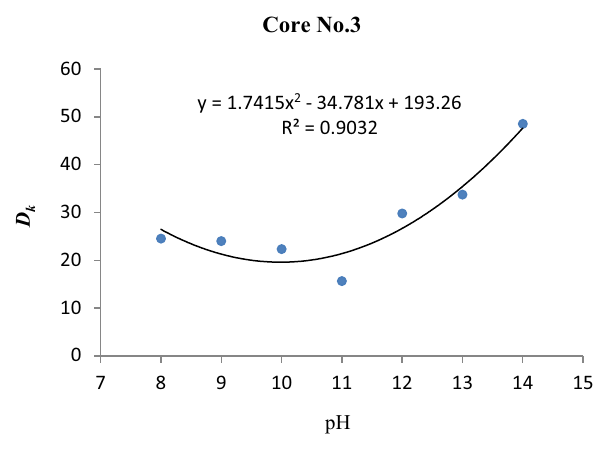
Fig. 12 Relationship between fluid alkalinity and D